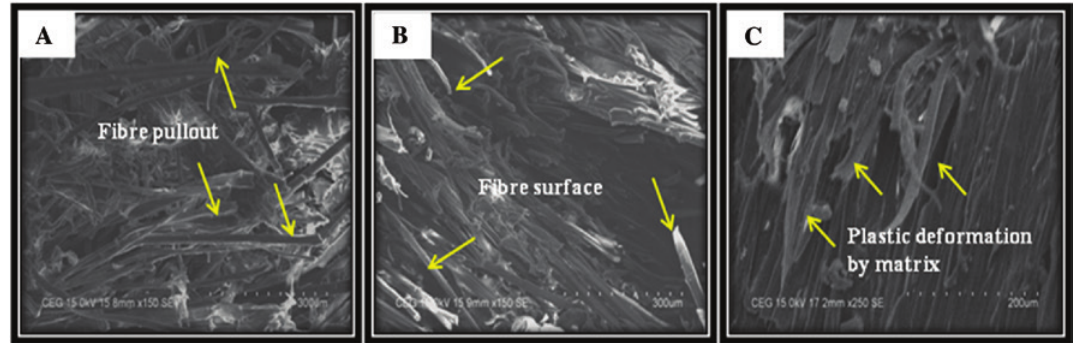
Figure 11: SEM images of impact fracture